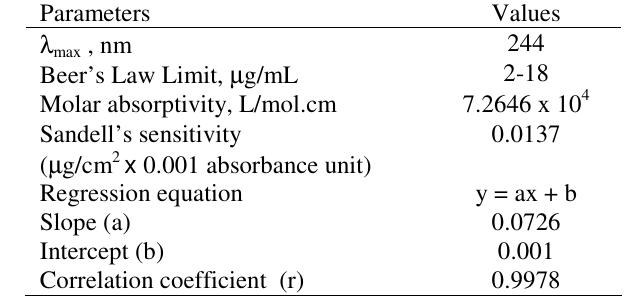
Table 1. Optical characteristics of ROSU.